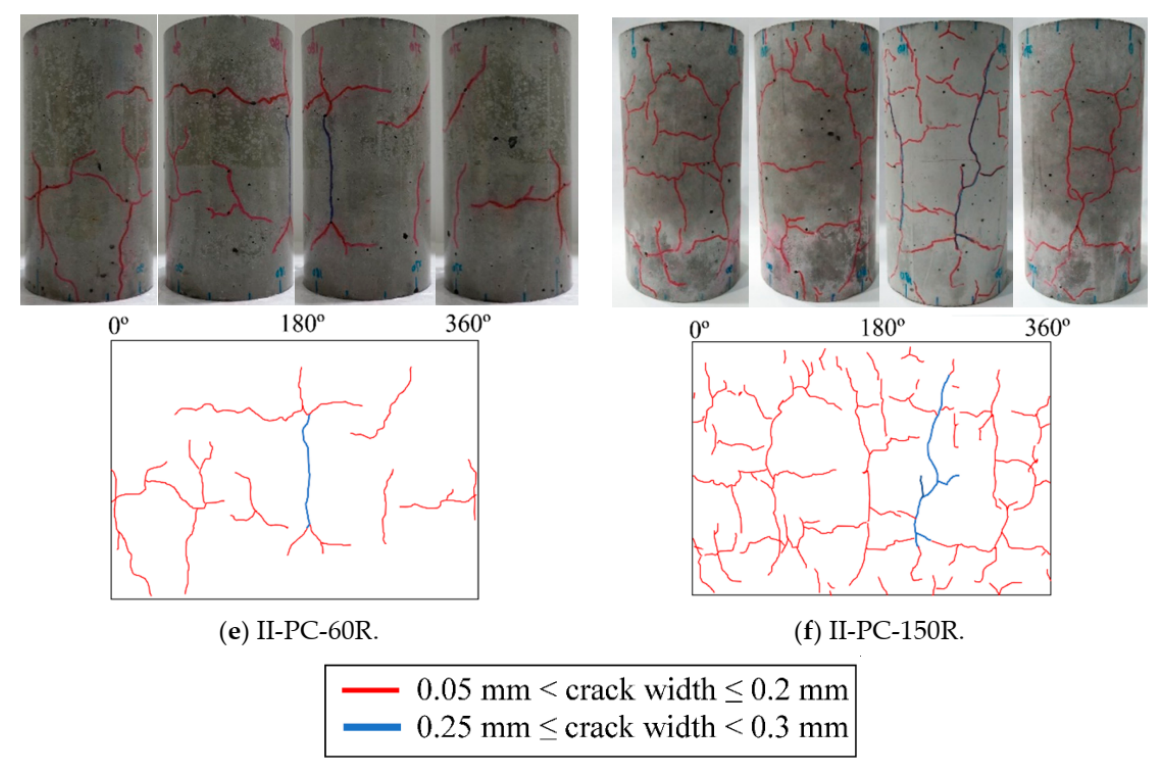
Figure 9. Specimen surfaces of series II specimens subjected to repeated high water